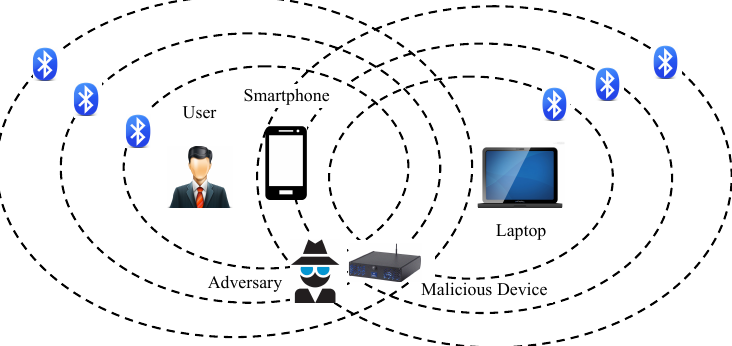
Figure 1. Privacy threat scenario in a typical Bluetooth application.